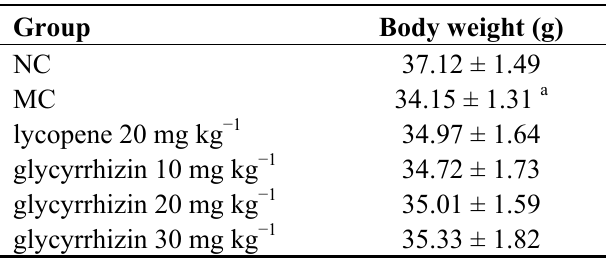
Table 1. Body weight in different